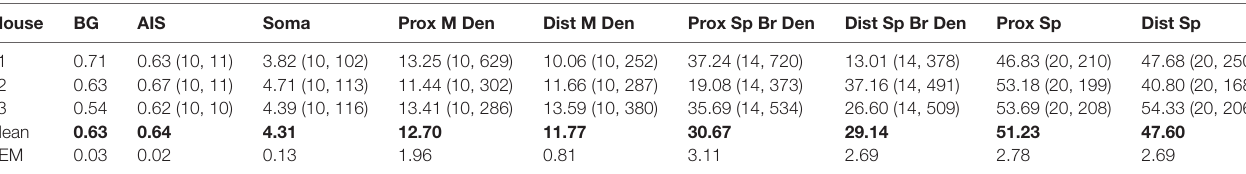
TABLE 2 | Densities of immunoparticles labeling the SK2 subunit in different axo-somato-dendritic compartments of Purkinje cells (PCs).